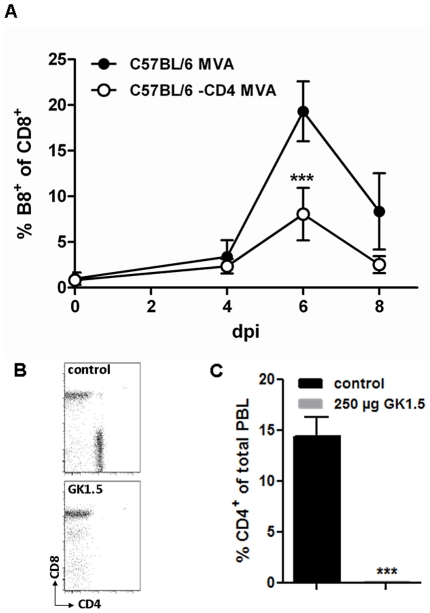
CD4+ depleted mice show a reduced CD8+ virus-specific T cell expansion upon MVA immunisation.C57BL/6 mice were treated twice with 250 µg anti-CD4 Ab (GK1.5 Harlan) two and one day prior to immunization with 2×105 pfu MVA. As control untreated mice were immunized with 2×105 pfu MVA. (A) The frequency of expanded B8R-specific CD8+ T cells in control mice (black) and CD4-depleted mice (white) was monitored within the blood at different time points post MVA immunization. (B) CD4+ T cell depletion efficiency was monitored at the day of immunization by flow cytometry of blood samples. CD4+ and CD8+ T cells within CD3+ population of blood lymphocytes are shown from representative mice. (C) CD4+ T cell depletion efficiency at 6 dpi, the day of maximal T cell expansion, was calculated as % CD4+ of total peripheral blood lymphocytes (PBL). Data shown are pooled from two independent experiments with n = 5 mice per group. Statistical significance is shown by *** p>0.0001 using two-tailed t-test.